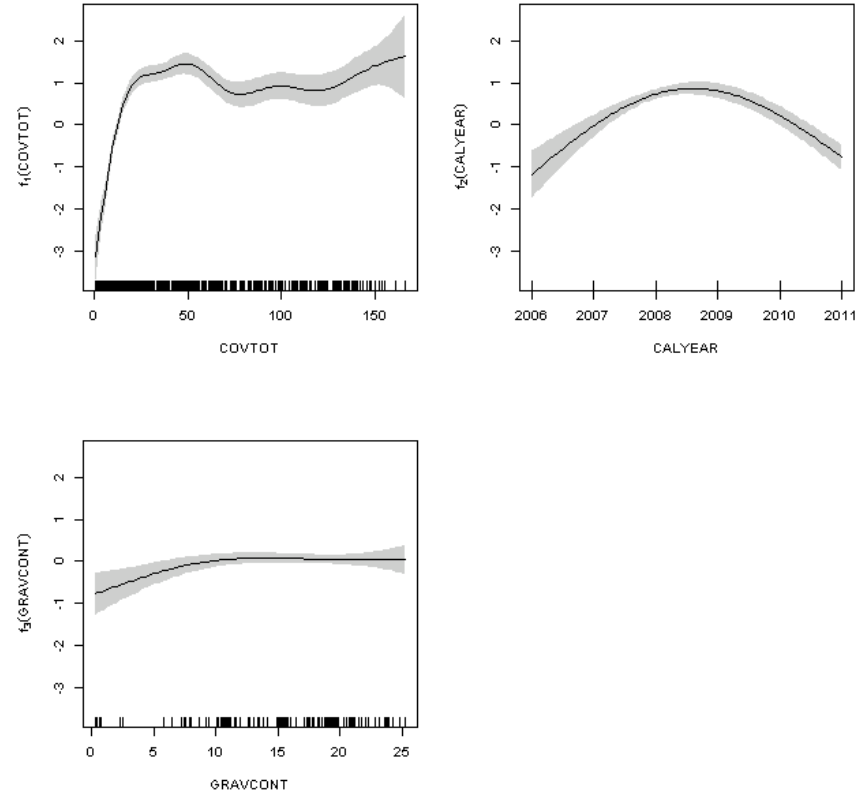
Fig. 7. Nonlinear effects of the total degree of coverage (COVTOT), calendar year (CALYEAR), and gravel content (GRAVCONT), on the Figure 7 1105 proportion of Fabaceae (PROPFAB) (see Eq. 15). Shaded: 95%-confidence area. Table 11. Parameter estimates and significances for the model estimating the proportion of Fabaceae (PROPFAB) as shown in Eq. (15). Significance levels: ***: p < 0.001, **: p < 0.01, *: p < 0.05. The variance of the random effect a in Eq. (15) is 0.2288. Trend: qualitative illustration of linear predictor variables’ significant influences. ↑ , ↓ : PROPFAB increases (decreases) with increasing values of the respective predictor